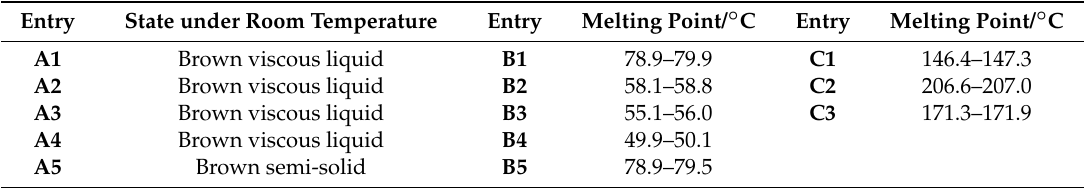
Table 2. The state and melting points of the synthesized ILs.